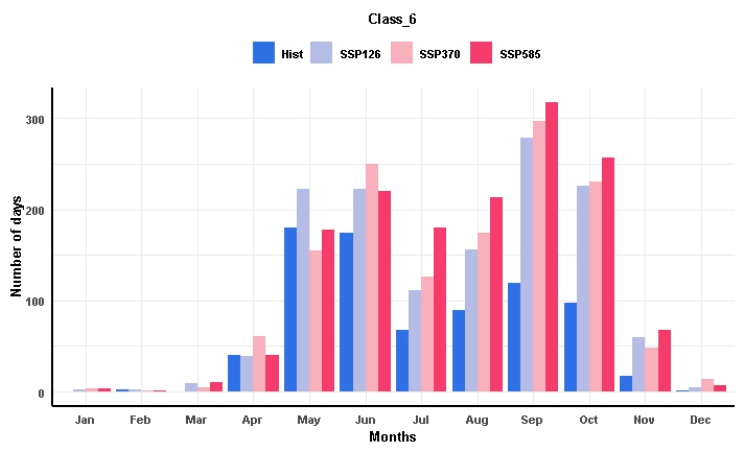
Figure 8. As in Figure 3 for CP6. In the CP7, low pressure is located in the Middle East and Iran. It is also present in the future, but in SSP370 and SSP585, high pressure (1020 hPa) is seen in the Mediterra- nean and North Africa. In the mid-level of the atmosphere, the trough stretches from the eastern Black Sea to Saudi Arabia and is predicted in future patterns. However, an in- crease in geopotential height at low latitudes and a high (590 dam) formation is also pre- dicted. The frequency of this pattern is higher in the spring months (April, March, and May) and then in January, February, November, and December. However, the frequency of its occurrence in the future increases considerably in different scenarios (Figure 9).